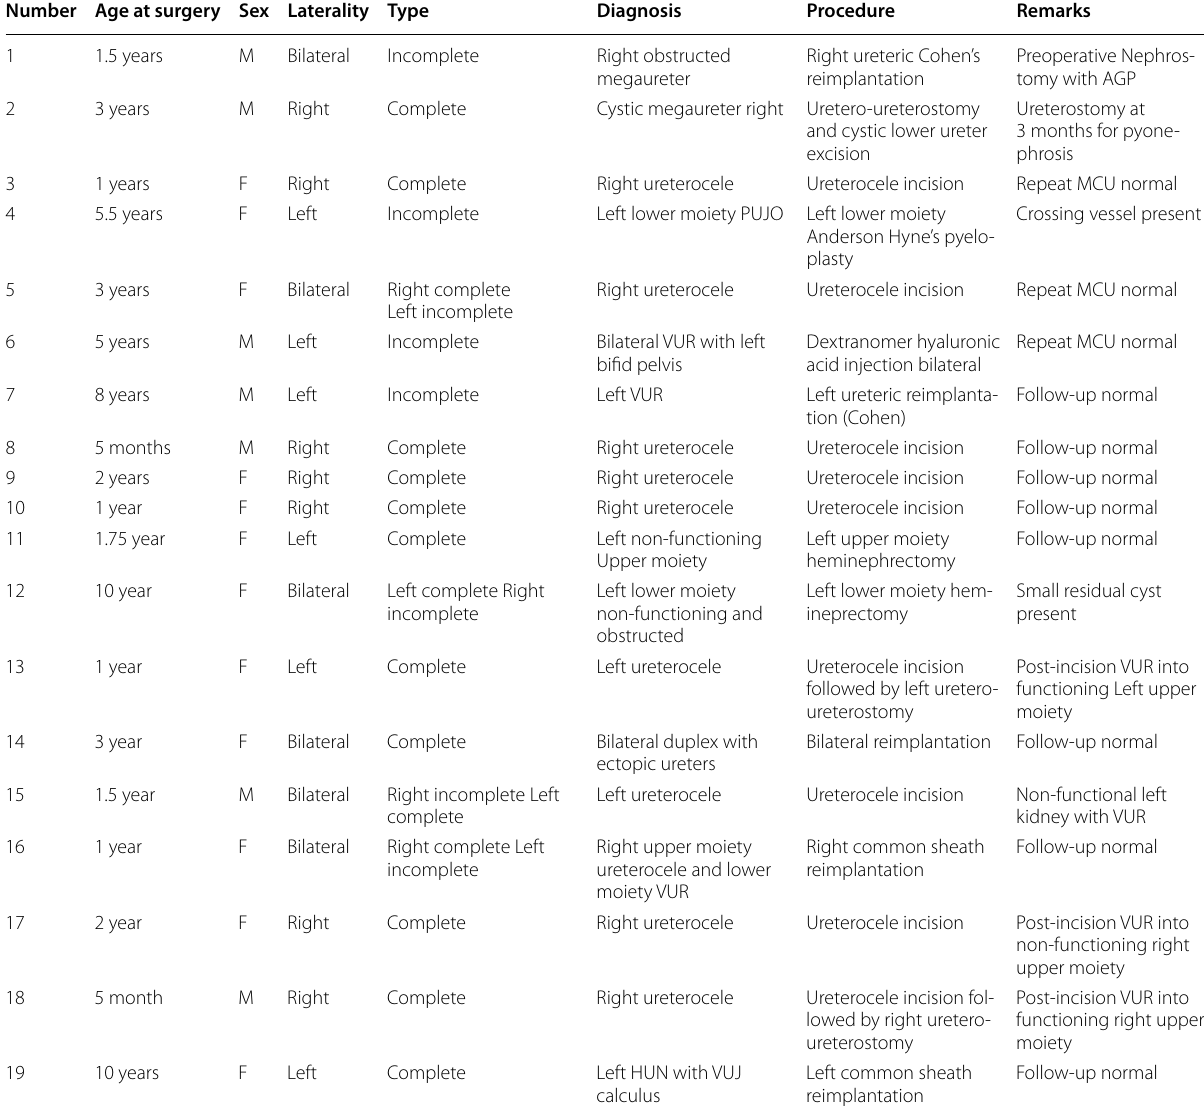
Table 1 List of patients with duplex kidneys who underwent surgical intervention Number Age at surgery Sex Laterality